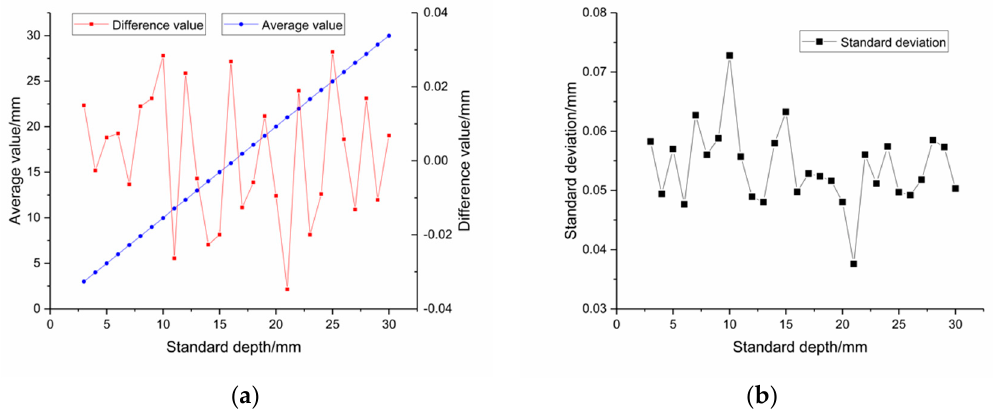
Figure 9. Measurement accuracy and repeatability analysis: ( a ) the average value and difference values under different standard depths; ( b ) the standard deviation curve of the repeatability experiment.